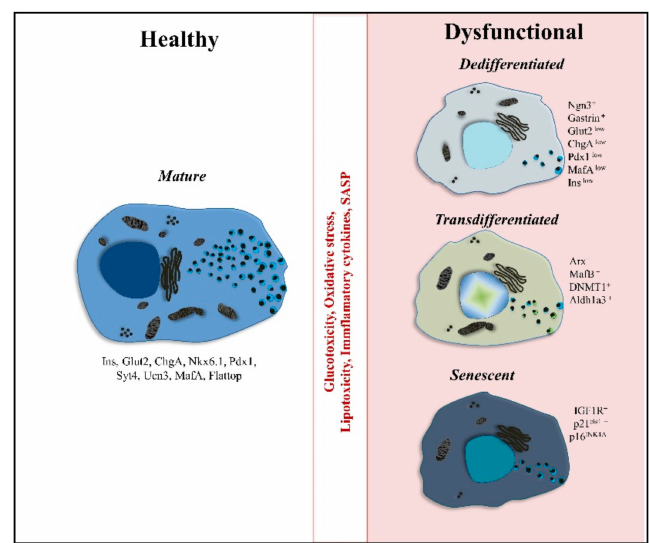
Figure3. Altered β -cellphenotypesindiabetes. Schematicrepresentationof β -celldescribedphenotypes as a response to diabetic environments. On the left side, a healthy mature β -cell is shown, in the middle box, disease stressors that induce changes in β -cell phenotype are mentioned, on the right side, summary of the three β -cell phenotypes observed in diabetes: immature / dedi ff erentiated, transdi ff erentiated and senescent, with each of the di ff erent phenotypes depicting the up- or down-regulation of key